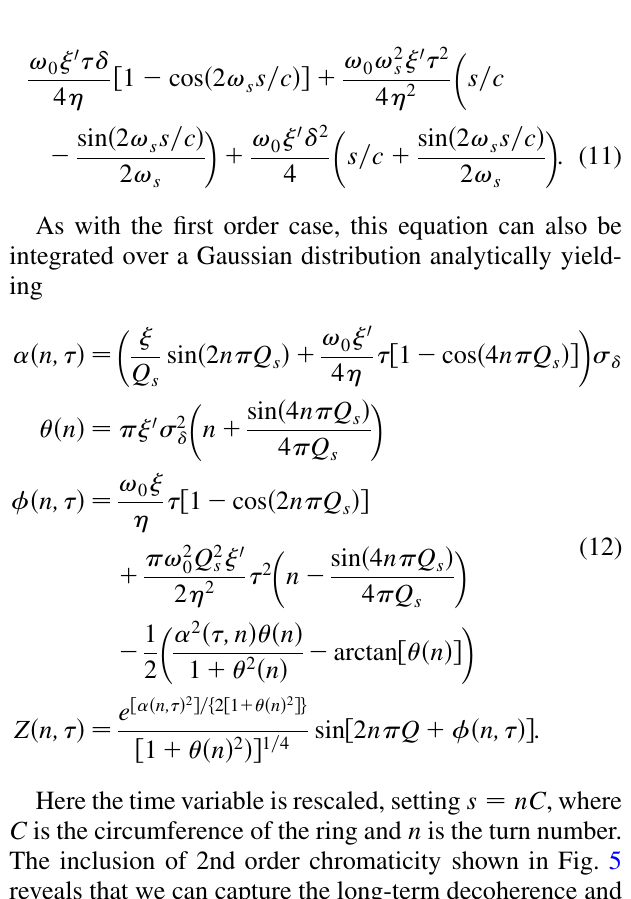
FIG. 3. (Color) Plot of Z (cid:3) n; (cid:1) (cid:4) measured versus n turns with (cid:1) (cid:5) 0 (bunch center). Shown is measured data of the transverse beam slice motion after 1 mm kick. With fixed rms bunch length (cid:8) 3 ns and decreasing chromaticity, we can see the depth of the decoherence envelope decrease, comparable to simple analytical model.